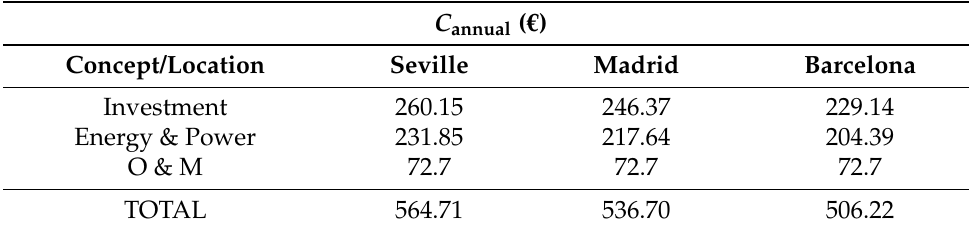
Table 5. Contribution of the different concepts to C annual